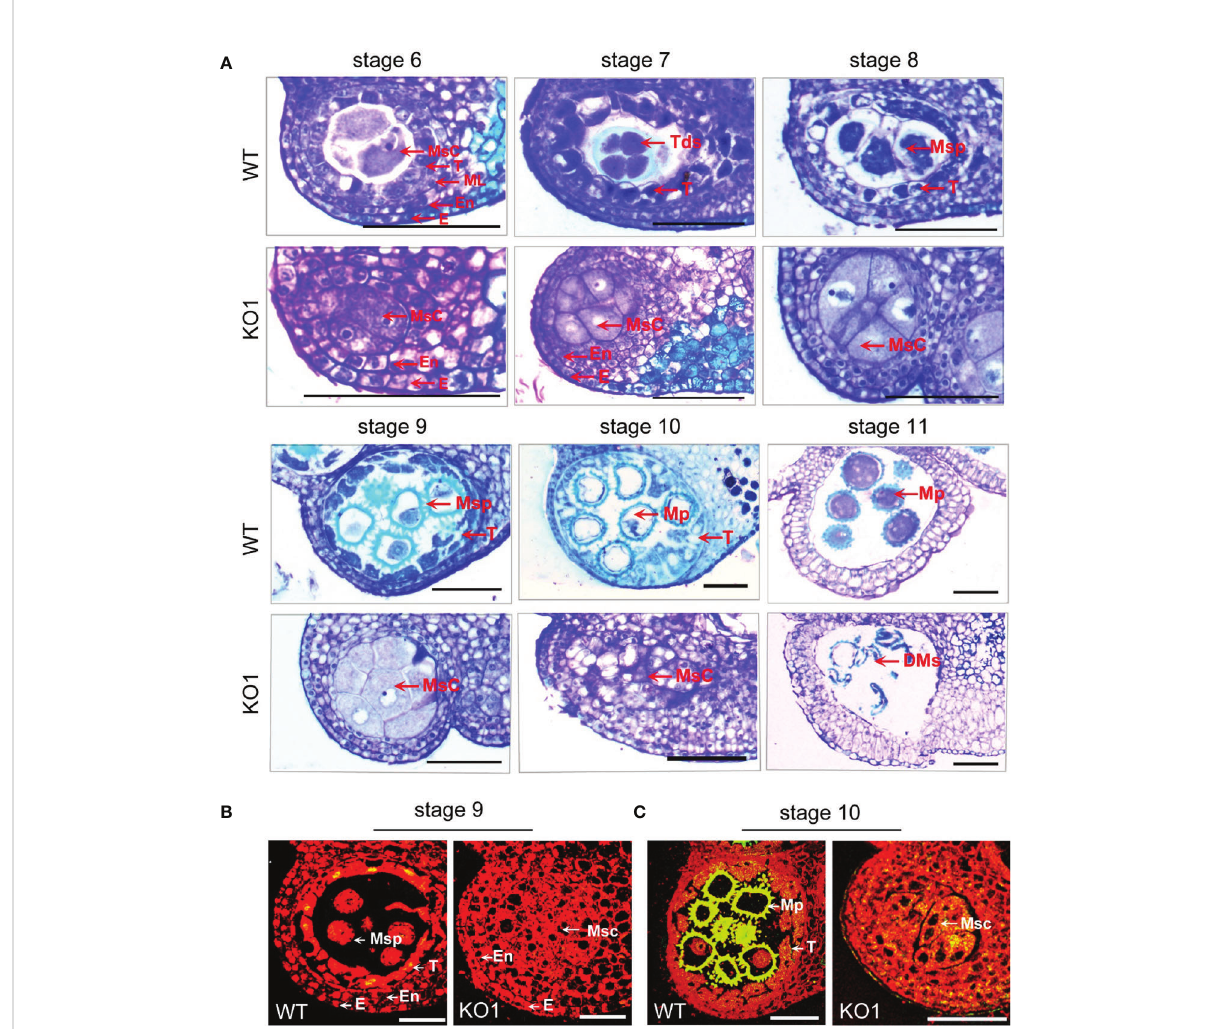
FIGURE 5 Comparison of the histological characteristics of the WT and KO1 sterile line T3 anthers. (A) Stage 6-11 histological characteristics of the WT and KO1, Scale bars: 100 µm (B, C) Analysis of DNA damage in anthers of WT and KO1 male-sterile plants. The degree of DNA fragmentation of anthers was detected by TUNEL. Scale bars: 100 µm. DMs: degenerated microspores; E, epidermis; En, endothecium; Msc, microsporocyte; Mp, mature pollen; ML, middle layer; Msp, microspore; T, tapetum; Tds, tetrads; WT, wild